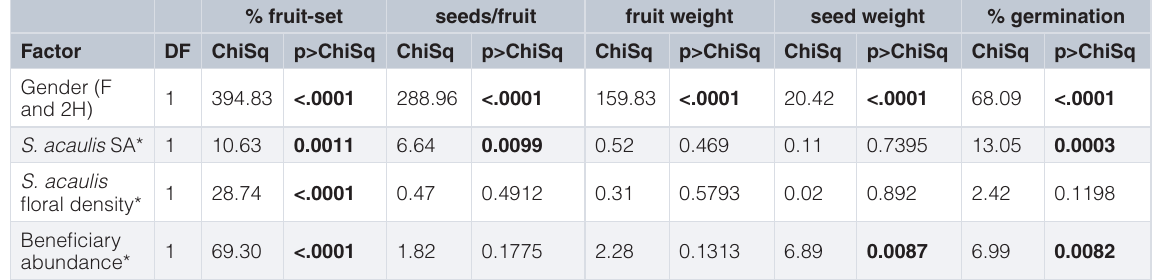
Figure 2. Reproductive output measures for female plants (white) and two times that of hermaphrodite plants (grey) under current and reduced pollination regimes. ± 1 standard error bars shown. Table 2. Summary of GLM results testing the effect of gender on measures of reproductive success under the current pollination regime with covariate measures of S. acaulis surface area (SA), S. acaulis floral density, and beneficiary abundance indicated by *. Reproductive measures for hermaphrodites are doubled. Significance is considered at p<0.05 and indicated in bold. % fruit-set seeds/fruit fruit